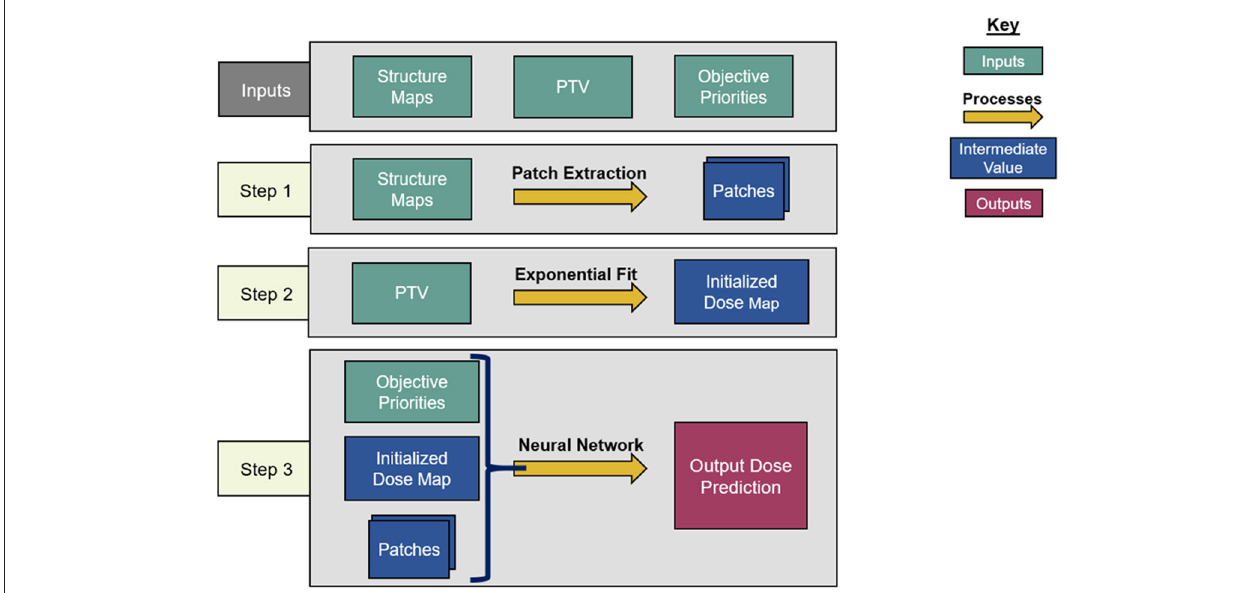
FIGURE 1 | Overview of the dose prediction model architecture.